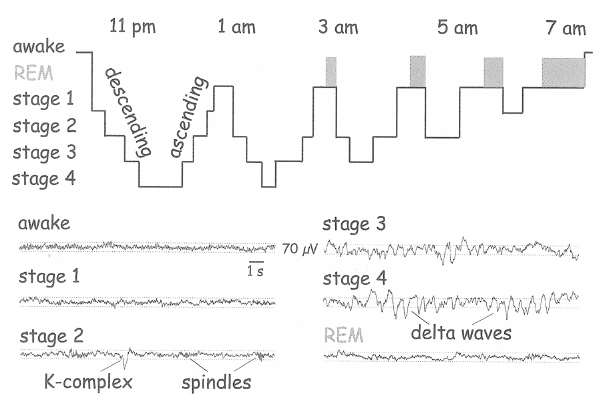
FIguRE 1 | Schematic illustration of the sequence of stages in normal human sleep. For the first hour or so, the brain is plunged into a deep functional abyss. As the night progresses, SWS episodes (Stages 1–4) become shorter, and REM episodes appear and become longer, culminating in wakefulness in the morning. The EEG (lower half of figure) reflects these state changes and reveals similarity between wakefulness and REM. (From